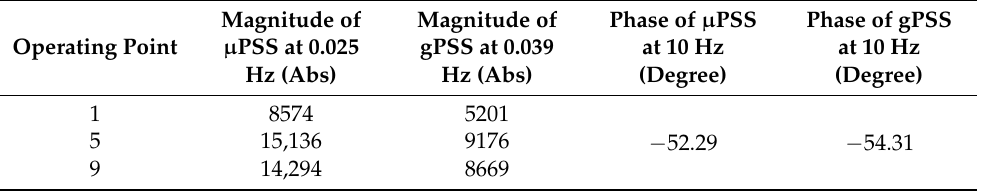
Table 5. Bode diagram analysis with 3 operating